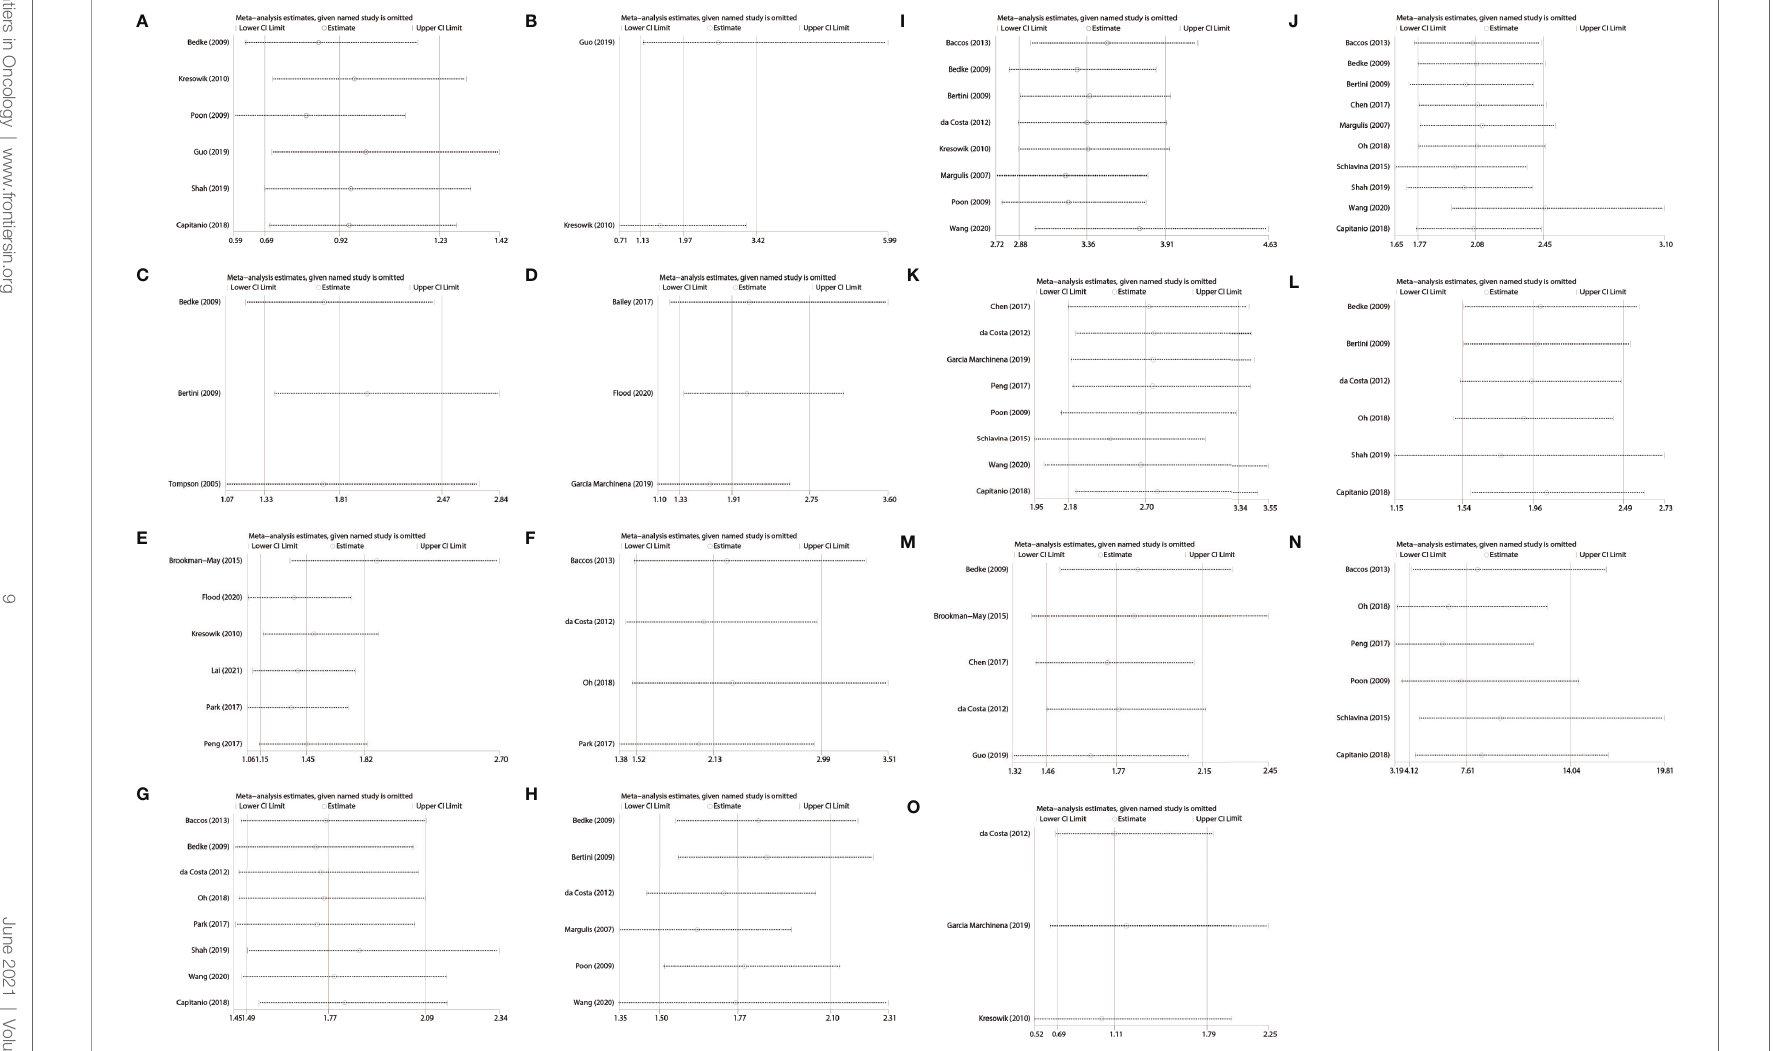
FIGURE 5 | Sensitive analysis of the included studies by one-removed analysis. (A) : SFI only vs PFI only; (B) : PFI + SFI vs SFI only; (C) : SFI ± PFI vs PFI only; (D) : PSI vs non-PSI; (E) : RVI vs non RVI; (F) : RVI + FI vs RVI or FI; (G) : multiple vs single pattern; (H) : lymph node involvement; (I) : distant metastases; (J) : sarcomatoid differentiation; (K) : Fuhrman grade (III, IV vs I, II); (L) , tumor necrosis; (M) : tumor size (> 7 cm vs ≤ 7 cm); (N) , positive margin status; (O) , lymphovascular invasion; SFI, sinus fat invasion; PFI, perinephric fat invasion; PSI, pelvicaliceal system invasion; RVI, renal vein invasion; FI, fat